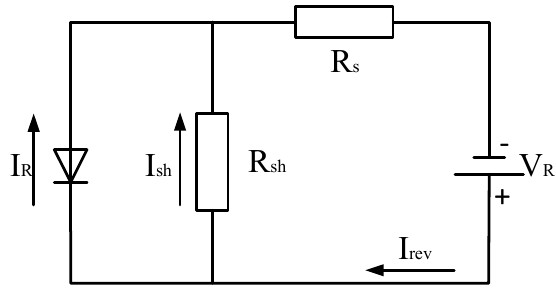
Figure 5. The reverse bias model of a crystalline silicon solar cell.